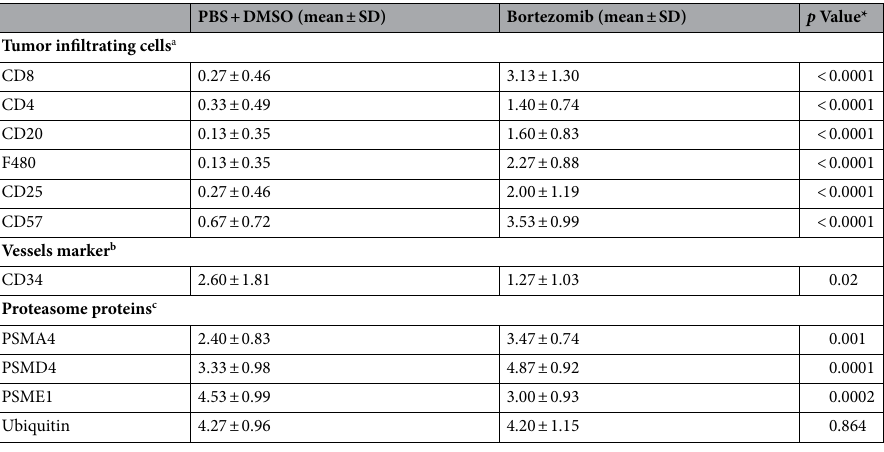
Table 2. Immunohistochemical evaluation of markers for tumor infiltrating cells and molecules involved in the proteasome activity. *Two-tailed Student’s T test. a Positive cell count/HPF averaging 5 representative microscopic fields. b Positive vessel count/HPF averaging 5 representative microscopic fields. c A combined scoring system was used for the IHC evaluation. Specifically, the total score (0–6) was obtained by adding the score associated to the number of positive cells and the score related to the signal intensity. The score associated to the number of positive cells was defined as follow: 0 (1 ≤ Positive cells/HPF), 1 (2 ≤ x ≤ 10 Positive cells/HPF), 2 (11 ≤ x ≤ 20 Positive cells/HPF), 3 (≥ 21 Positive cells/HPF). The score related to the signal intensity was defined as follow: 0 (absent/very low Intensity/HPF), 1 (low Intensity/HPF), 2 (moderate Intensity/HPF), 3 (high